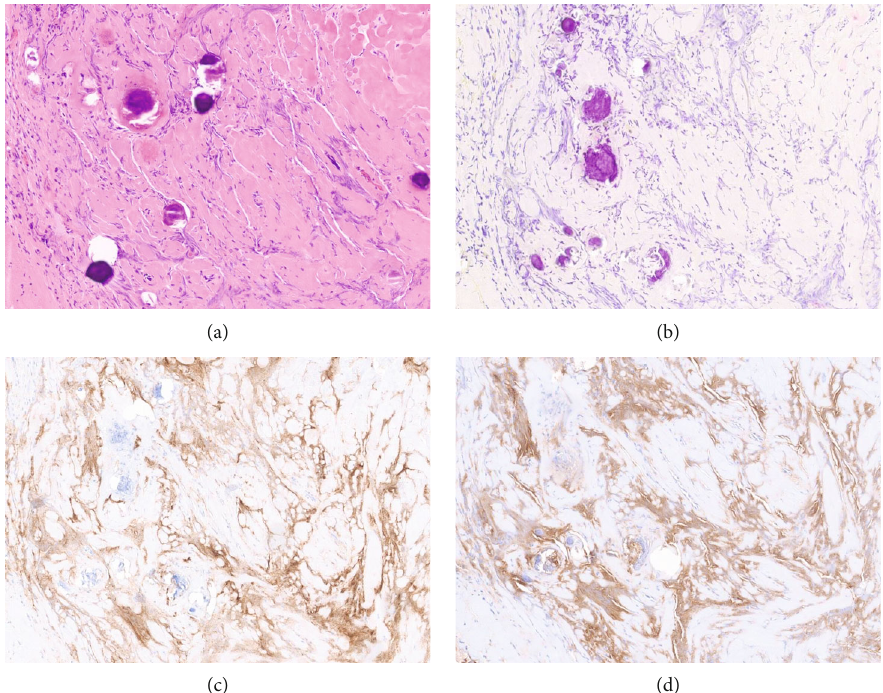
Figure 2: (a) Separate fi brous fragment with psammomatous calci fi cations and vague bland spindled to ovoid cells is shown. This fragment is negative for (b) SOX-10 and positive for (c) EMA and (d) SSTR2A (all images at